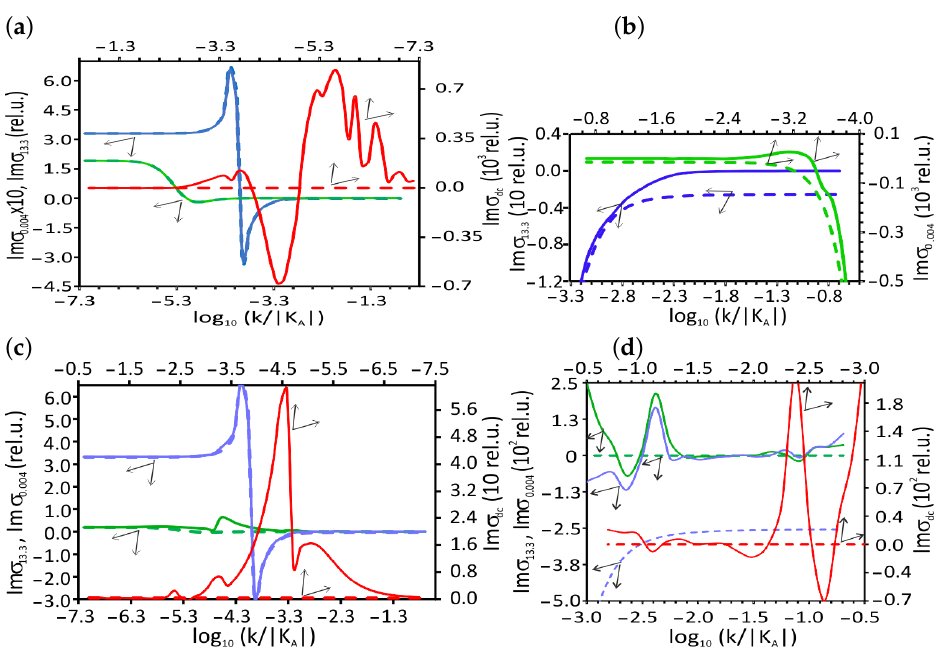
( ω , k ) of longitudinal ohmic contribution to conductivity vs. wave Figure 4. Imaginary part σ O L number k , (cid:126) k = (cid:126) p − (cid:126) K A ( B ) for our pseudo Majorana fermion N F = 3-model (Equations (8) and (9)) without ( a , b ) and with ( c , d ) the pseudo Majorana mass term (solid curves) and for the massless Dirac fermion model (dashed curves), at the temperature 100 K and the frequencies ω : 13.3 K (0.27 THz, blue color), 0.004 K (83 MHz, green color), 10 − 10 K (2.08 Hz, red color); the chemical potential equals to 1 K. The inset ( b ) to the figure ( a ) demonstrates the (cid:61) m σ O in a neighborhood of large k at the L frequencies 13.3 and 0.004 K; the inset ( d ) to the figure ( c ) demonstrates the (cid:61) m σ O in the region L of large k at the all frequencies for the case taking into account of the pseudo Majorana mass term. ( ω , k ) is measured in quantum conductance units of e 2 / h and labeled as (cid:61) m σ (cid:61) m σ σ O 13.3 , 0.004 and L − 10 K, respectively. (cid:61) m σ dc for the frequencies 13.3, 0.004, and 10 ( ω , k ) in the Table 1. Asymptotic behavior of the longitudinal-conductivity imaginary part (cid:61) m σ O L massless pseudo Dirac fermion monolayer-graphene N F = 2-model and in the pseudo Majorana fermion monolayer-graphene N F = 3-model for the case taking into account of the pseudo-Majorana mass term (mass case) and without the mass term (massless) at different frequencies ω and the large and small wave numbers k ∞ and k 0 , namely, at 0.2 | K A | and 6.5 · 10 − 8 | K A | , respectively; at the ( ω , k ) is measured in quantum conductance temperature 100 K and the chemical potential 1 K; σ O L units of e 2 / h . (cid:61) m σ O ( ω , k ∞ ) L ω , K